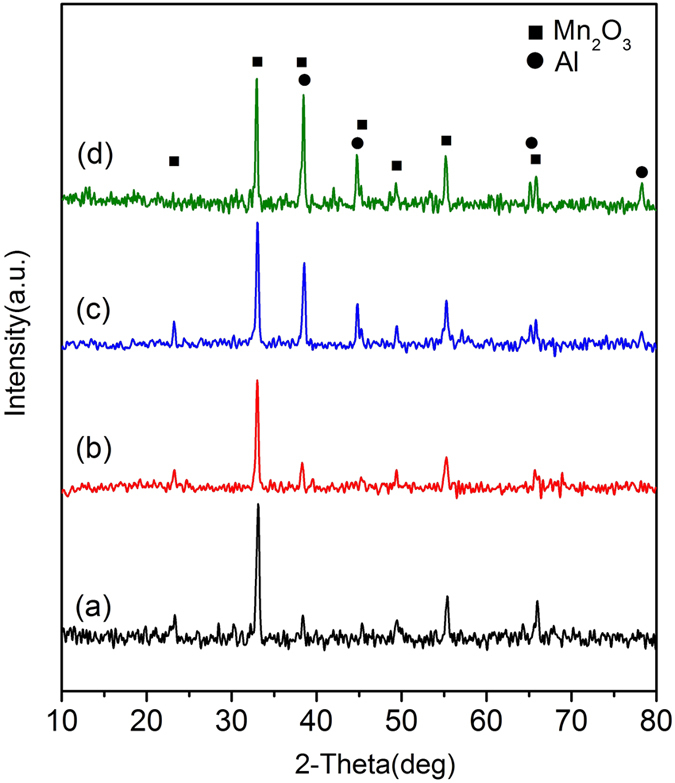
XRD patterns of (a) 3DOM Mn2O3 skeleton, (b) Mn2O3 nanoparticle, (c) 3DOM Mn2O3/Al membrane, (d) Mn2O3/Al nanoparticle composites.